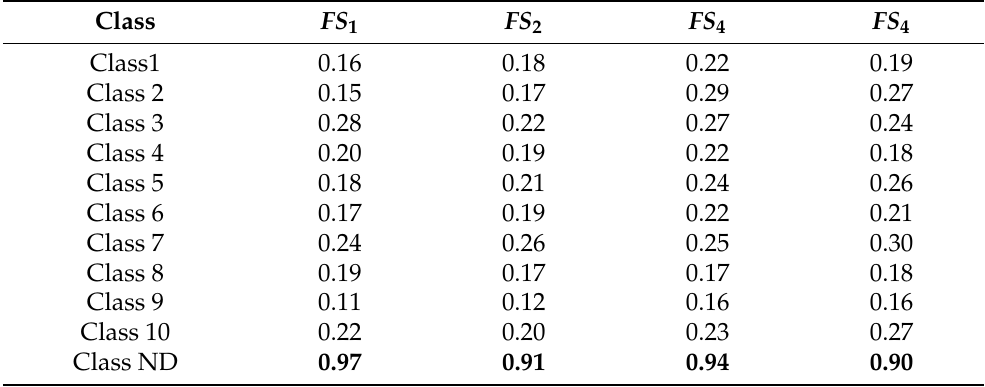
Table 10. FS 1 , FS 2 , FS 3 and FS 4 values obtained by comparing the EC maps of classes without defects with the remaining classes (the values highlighted in bold refer to the best